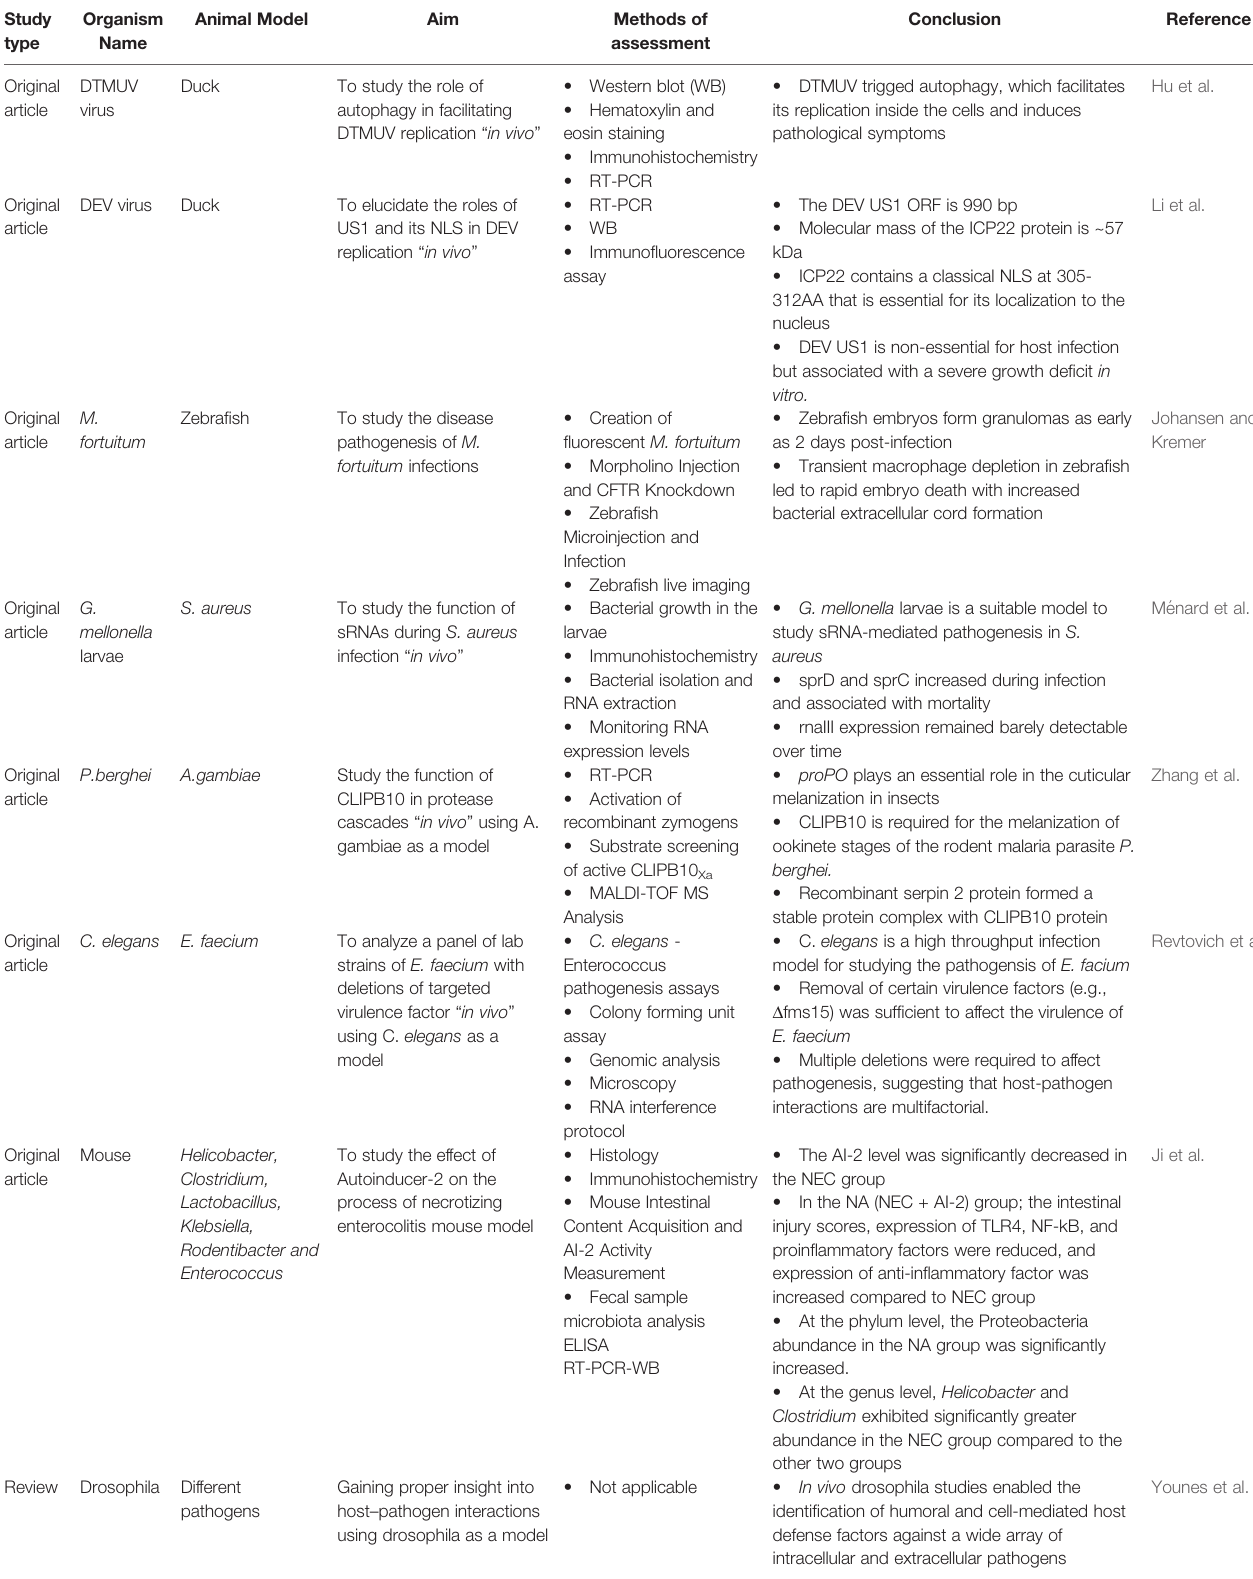
TABLE 1 | Summary for the outcomes of all accepted articles in this special